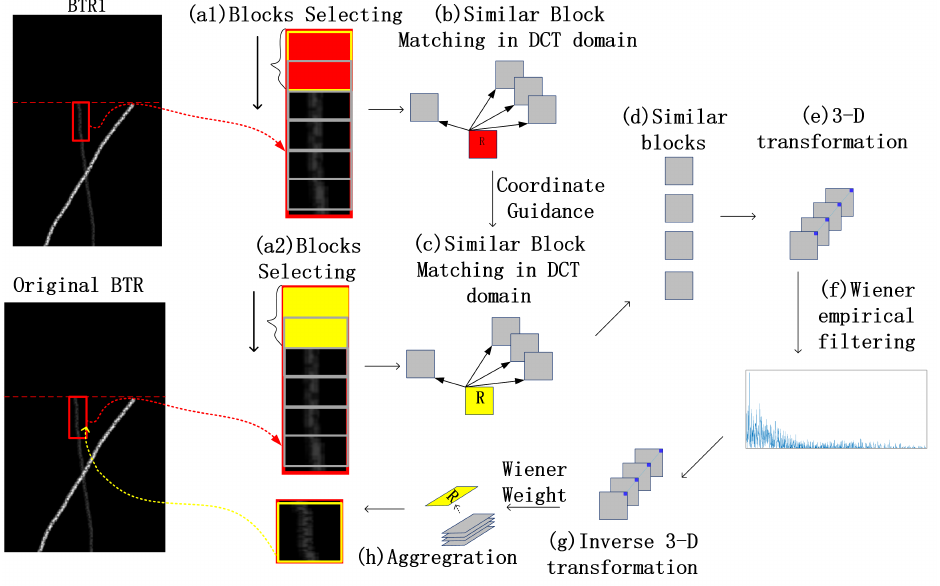
Figure 3. Frame of Wiener empirical